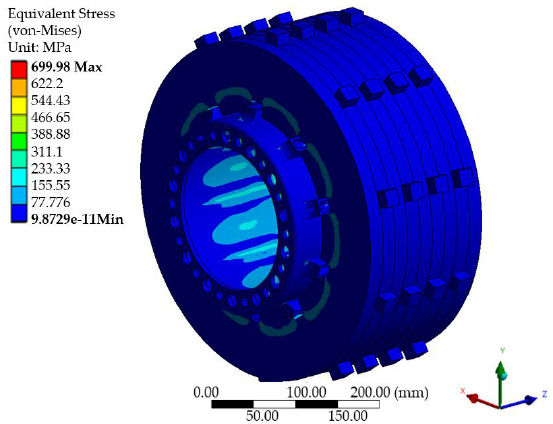
Figure 7. Von Misses stress of the brake assembly .